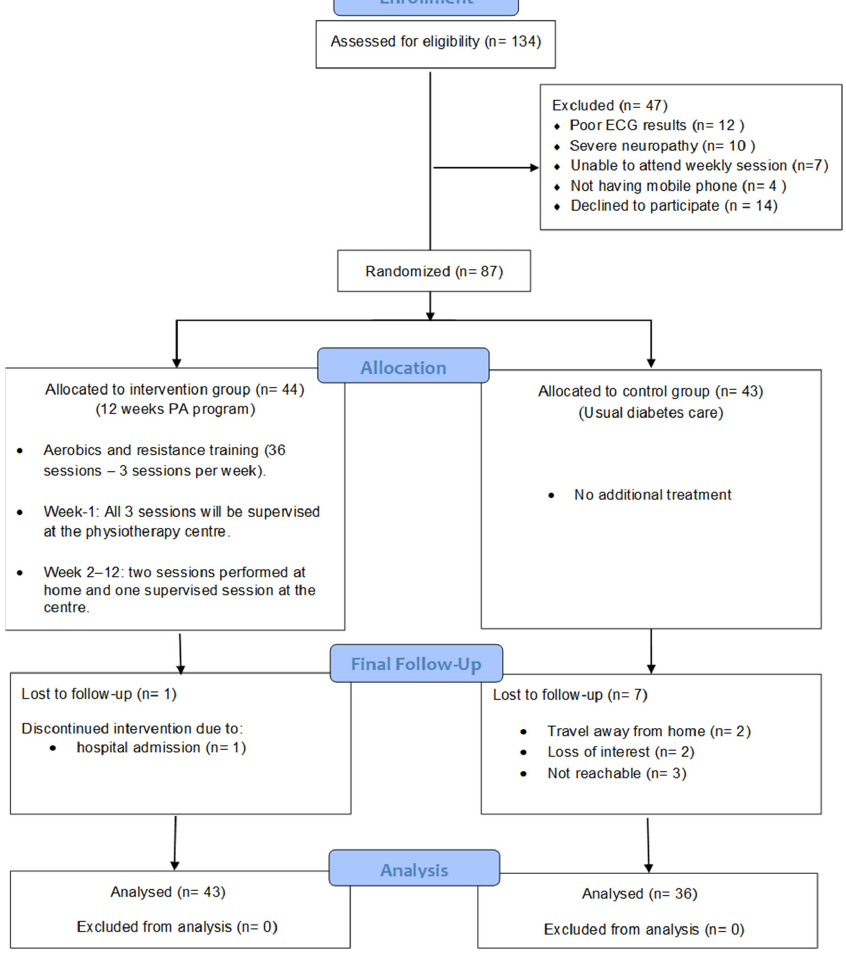
Figure 2. Participant fl ow chart.